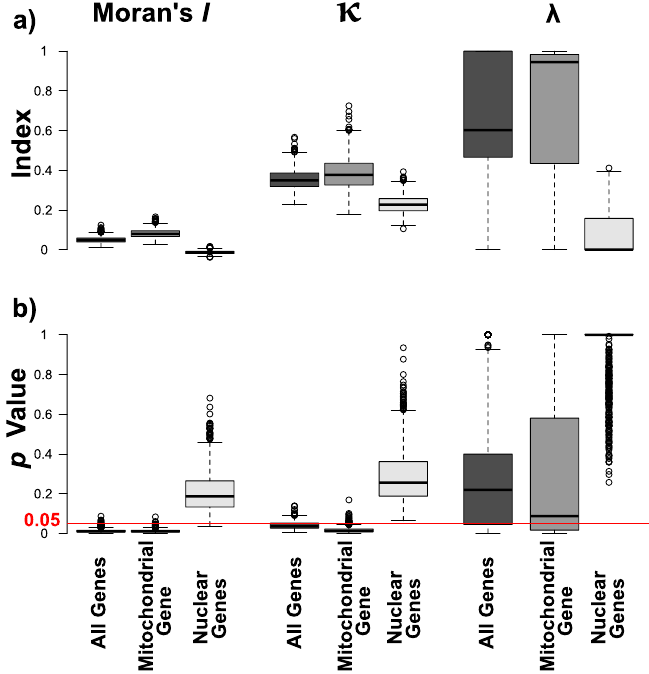
Figure 3. Summary of phylogenetic estimates across 1000 post burn-in trees for each dataset. Boxplots depict ( a ) the observed estimates for Moran’s I , Blomberg’s κ and Pagel’s λ with their ( b ) associated p values. The red line highlights a p value cut-off of 0.05.